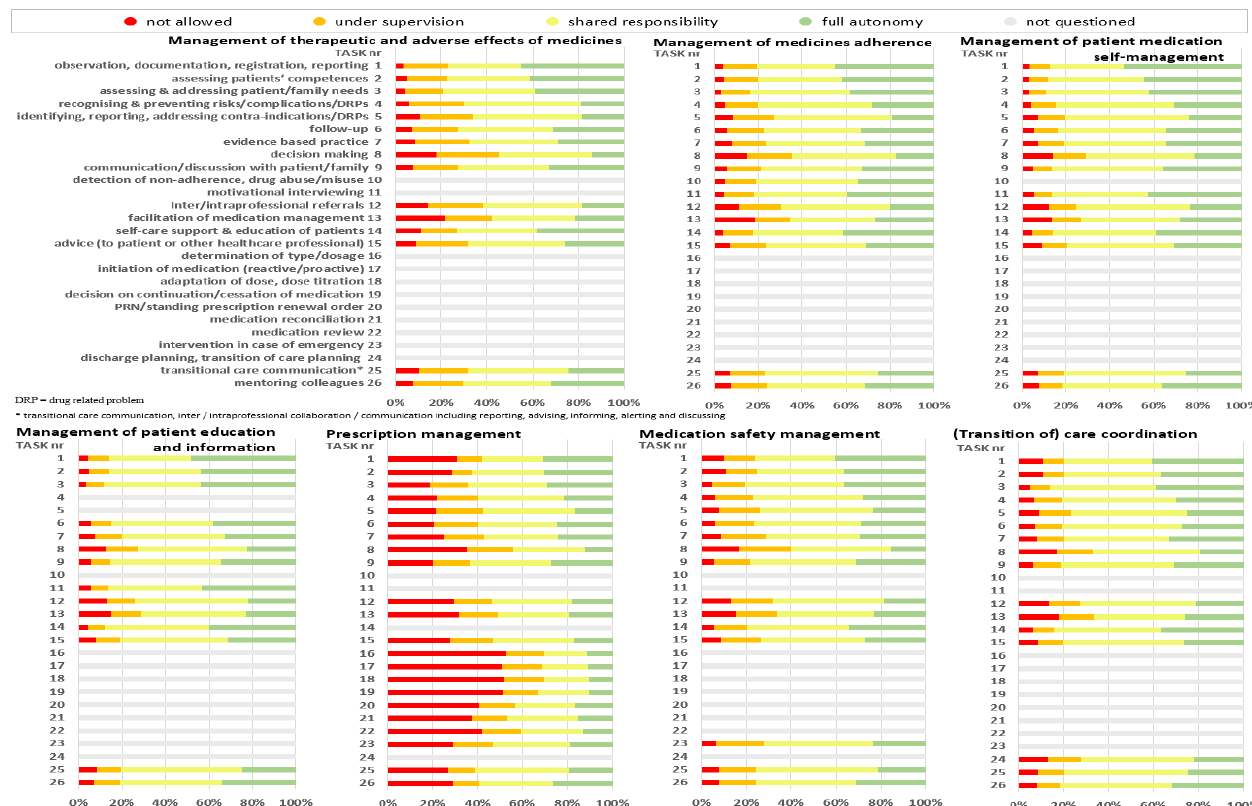
Figure 2. Healthcare workers’ opinion about the degree of nurse responsibility in 7 pharmaceutical care domains (n = 1385)